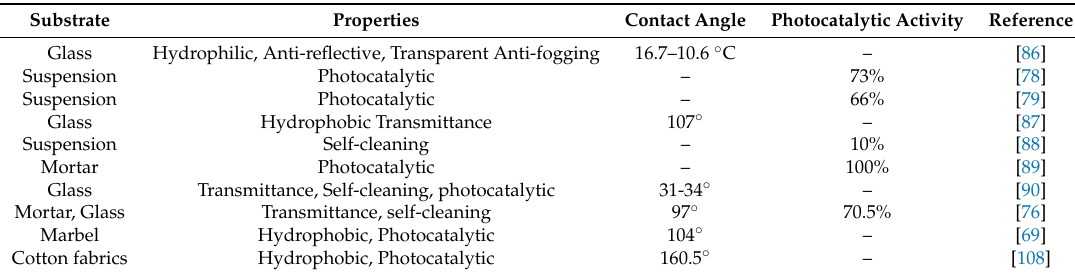
Table 2. Properties of the SiO 2 –TiO 2